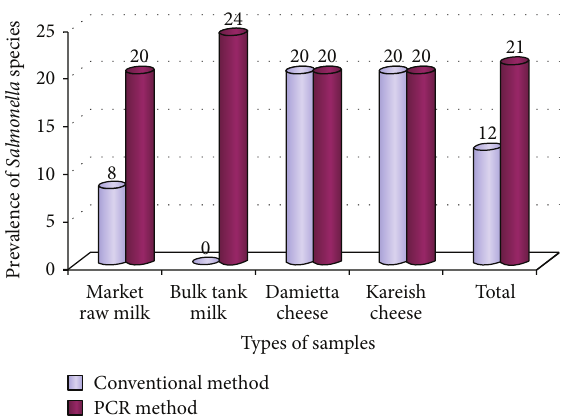
Figure1:Prevalenceof Salmonella speciesintheexaminedmilkand dairy products samples.